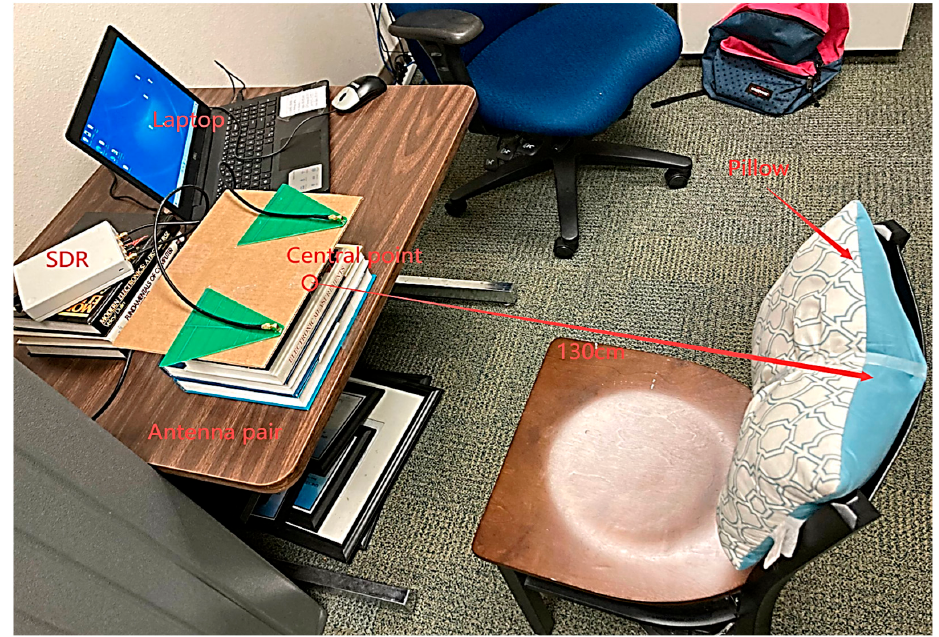
Figure 8. An example of the clinical trial setup of our NCVS system in a room of the TTUHSC Physicians Clinic.